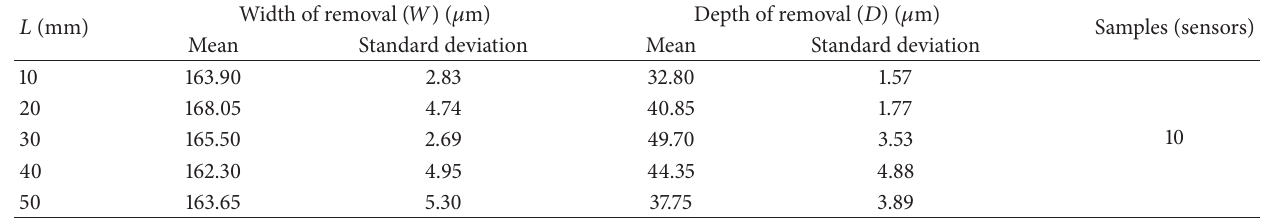
Table 2: The size matching of various 𝐿 s with the coupling and decoupling structure.